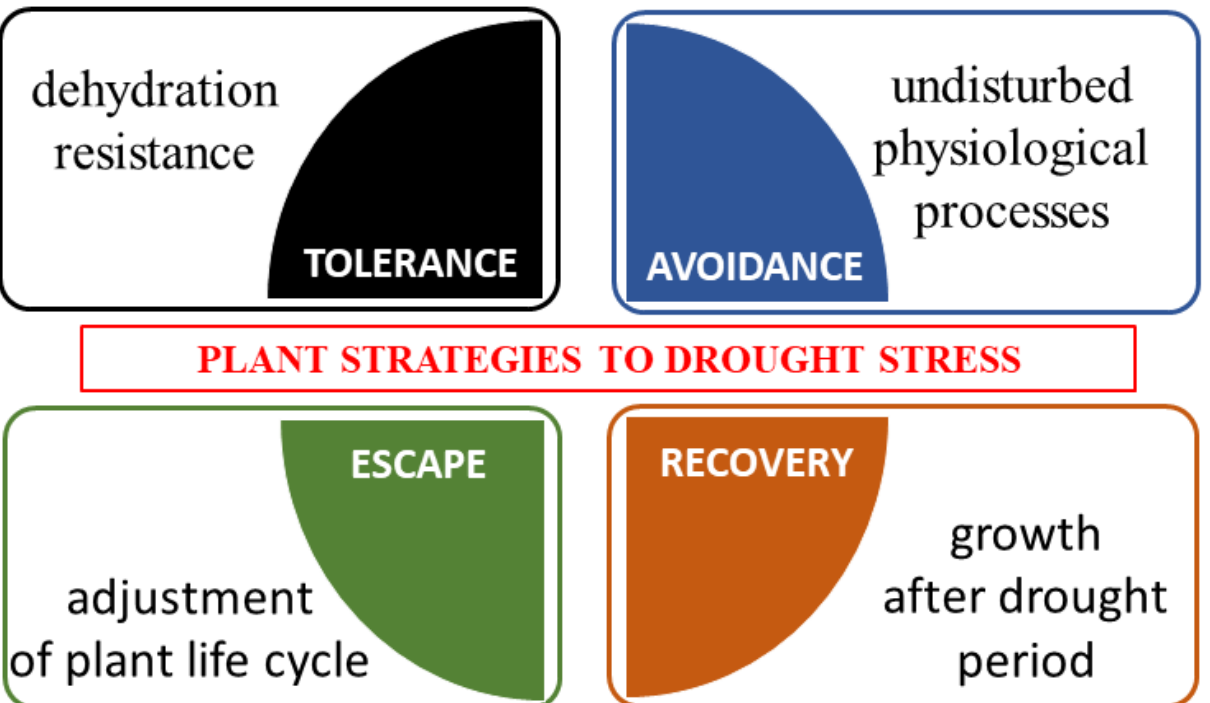
Figure 2. Response strategies to drought stress (modified on the basis of [1,39,50,51]).